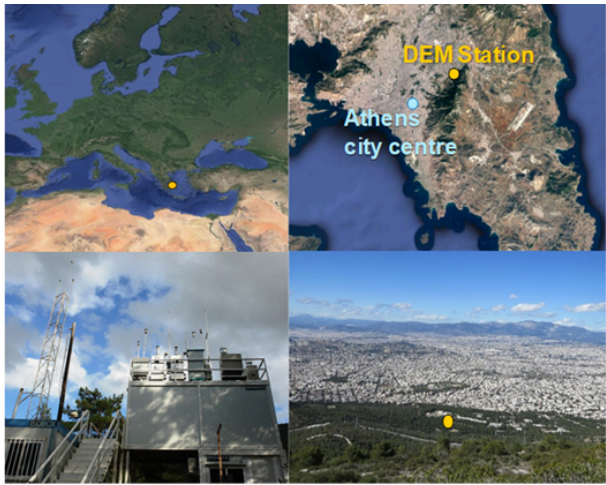
Figure 1. The Demokritos atmospheric aerosol measurement sta- tion in Athens (from © Google